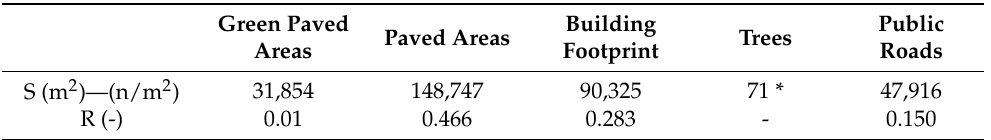
Table 3. Main characteristics of the district considered: in the table, S stands for surface (for trees it is measured as the number of trees per square meter [n/m 2 ]) and R stands for ratio (it is calculated with respect the total surface of the industrial district considered).